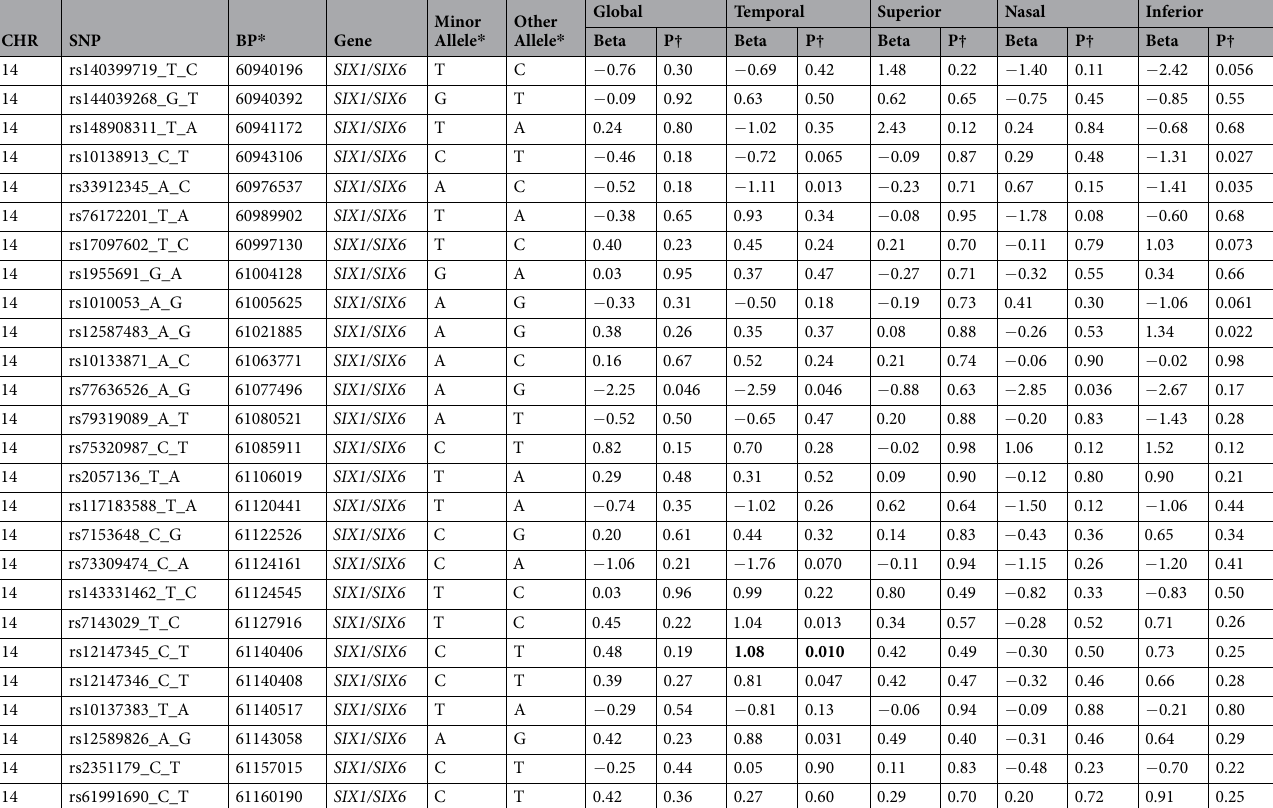
Table 2. Associations of a SIX1/SIX6 locus and circumpapillary retinal nerve fibre layer thickness including 4 sectors. CHR, chromosome; SNP, single nucleotide polymorphism; BP, base pair. * Positions and alleles are given relative to the positive strand of NCBI build 37 of the human genome. † Linear regression analyses were applied assuming additive effect of the per minor allele variant, adjusted for age and sex. Significant (P < 4.8 × 10 − 4 ) or suggestive (P < 0.0125) associations are shown in